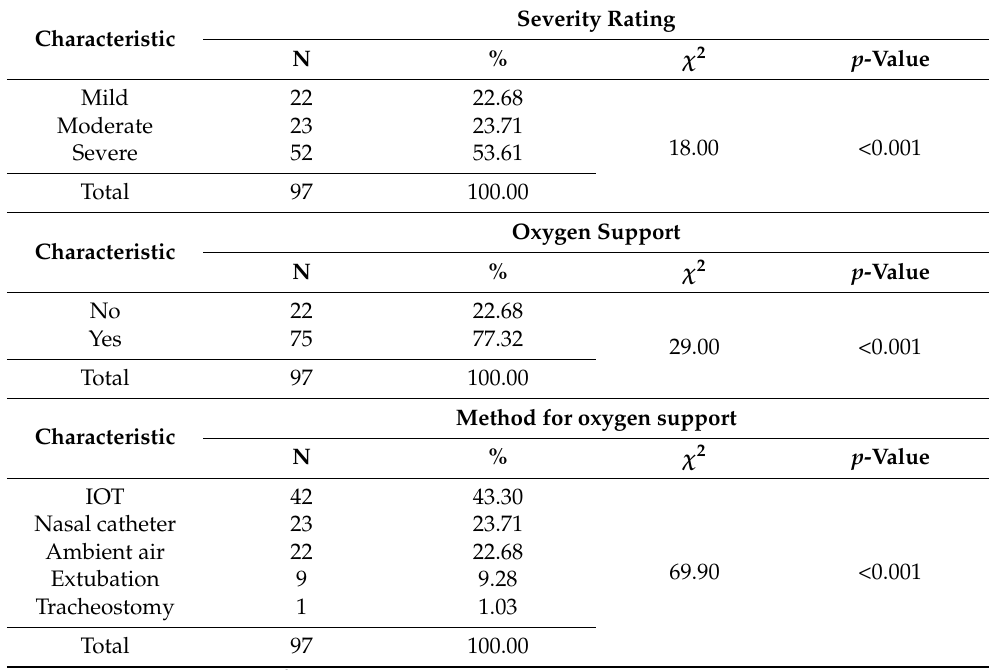
Table 3. Evaluation of frequencies for classification of severity, oxygen support, and method for oxygen support in hospitalized patients in a hospital in the Tri â ngulo Mineiro region, Brazil.